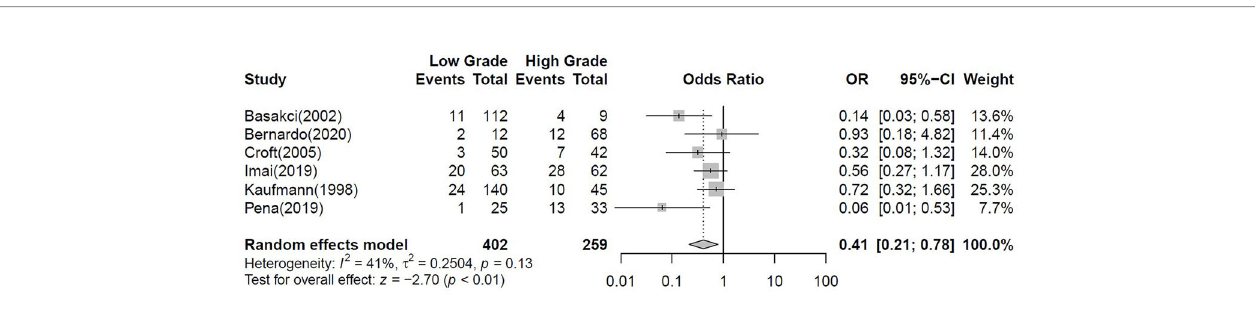
FIGURE 3 | Forest plot for the binary meta-analysis stablishing the association between ER a positivity and tumour grade. Individual study estimates of crude odds ratios (OR) and 95% con fi dence intervals (CI). The diamond at the bottom of the plot denotes the random effects estimate. Error bars indicate con fi dence intervals. Heterogeneity was assessed using